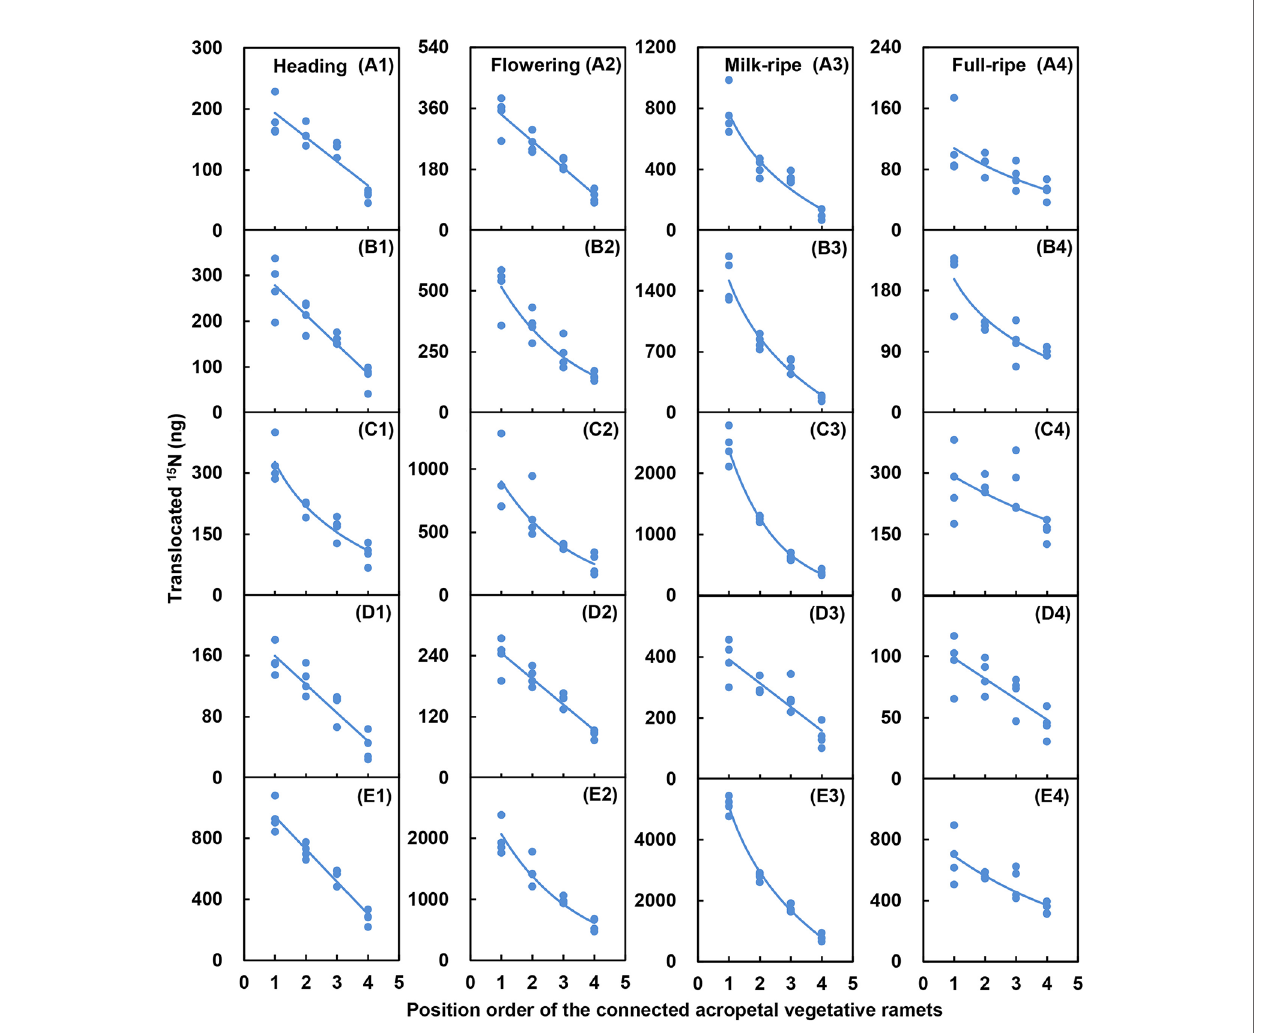
FIGURE 4 | Relationships between the amounts of translocated 15 N in the leaf blade (A1 – A4), sheath (B1 – B4), stem (C1 – C4), in fl orescence (D1 – D4), and whole ramet (E1 – E4) of reproductive ramets and the position order of the connected acropetal vegetative ramets at heading stage, fl owering stage, milk-ripe stage and full- ripe stage, respectively. The regression lines are based upon regression